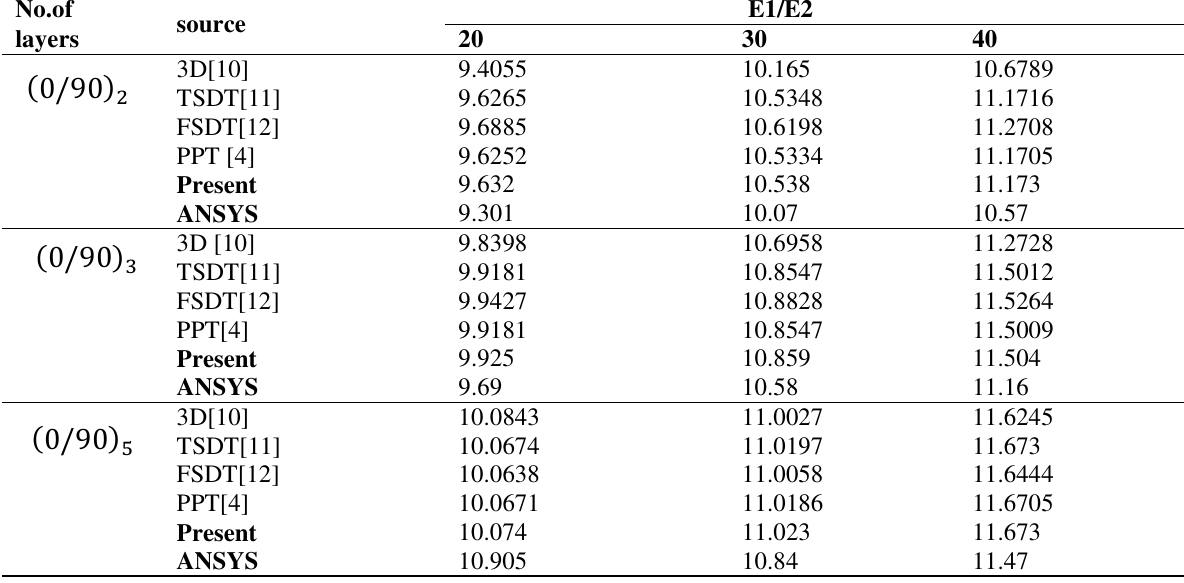
Non-dimensional natural frequencies of cross-ply square laminate No of layer